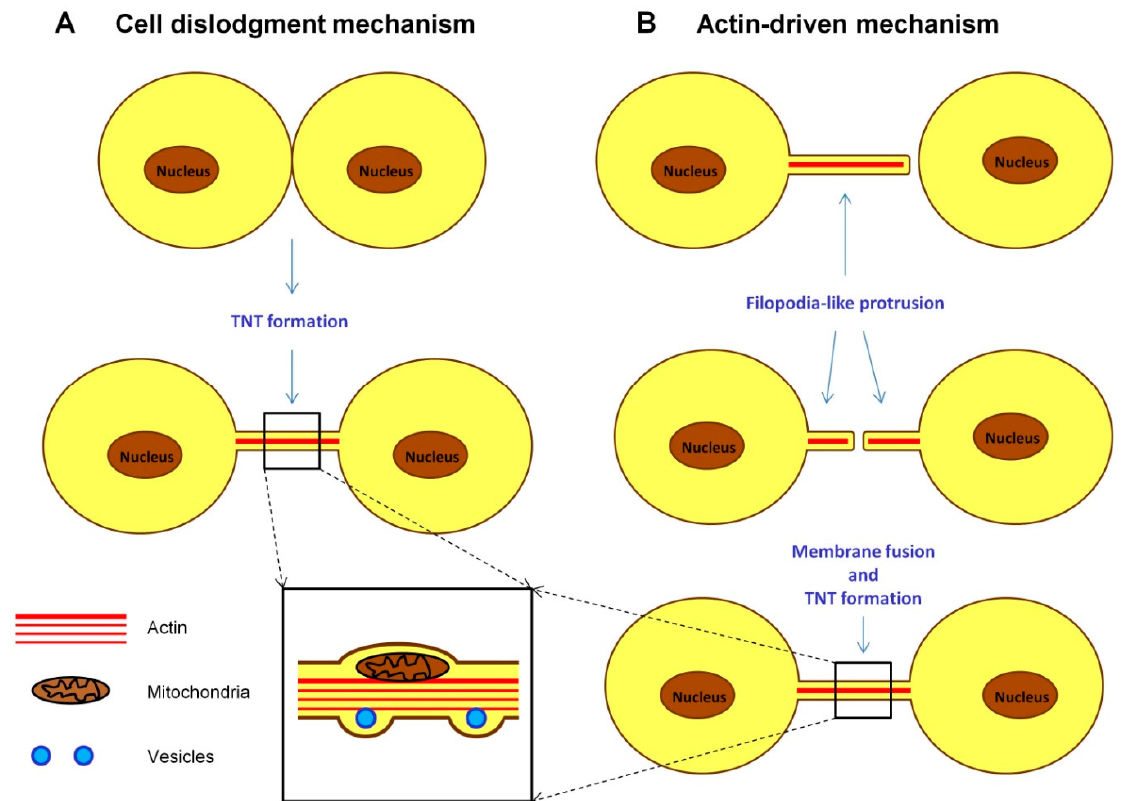
Figure 3. Mechanisms of tunneling nanotube formation. ( A ) Cell dislodgement mechanism involves the temporary fusion of two cells, followed by the formation of a nanotube during their separation. ( B ) Actin-driven mechanism involves the formation of filopodial protrusions by one or two cells, with their subsequent fusion. Importantly, TNT formation always ends with the fusion of the membranes of two cells, in contrast to the cytonemes, which establish contacts between cells without cell fusion. The organelles and other cellular components can be transported inside TNTs, with the diameter of TNTs increasing in the region of cargo passage.